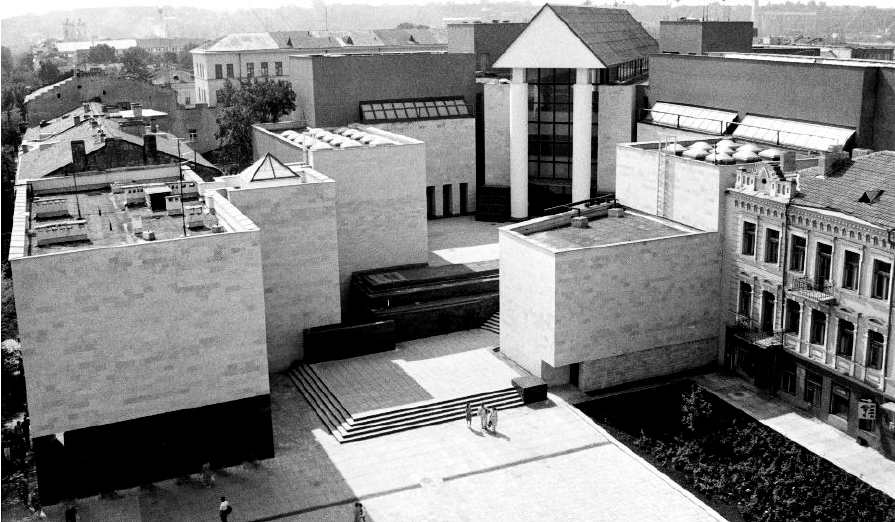
Figure 10. Mykolas Žilinskas Art Gallery in Kaunas, designed in 1981 by E. Mili ū nas, K. Kisielius and S. Juškys, built in 1988. From the Central State Archives of Lithuania. and S. Juškys, built in 1988. From the Central State Archives of